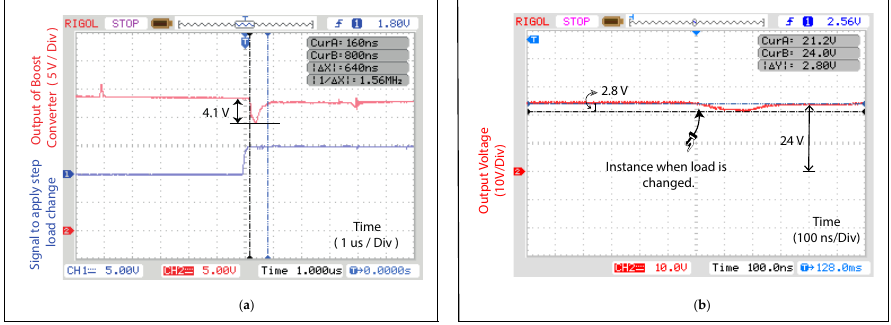
Figure 10. Experiment waveform of the output voltage when an additional load of 47 Ω is connected in parallel to 82 Ω load. ( a ) conventional current-mode controller; ( b ) fixed frequency